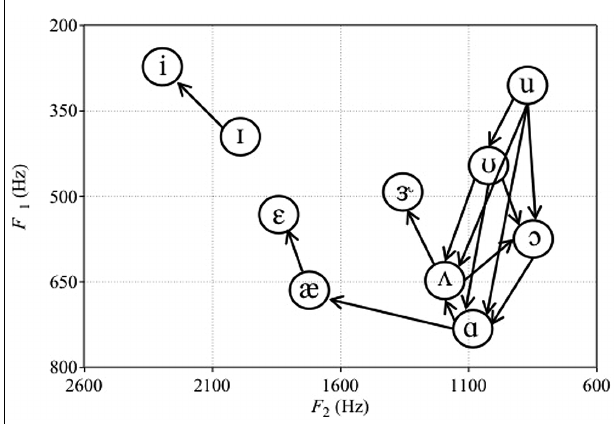
FIGURE 1 | Plot of the asymmetries in vowel discrimination of vervets from Sinnott (1989). Arrows represent the direction of change that was easier to discriminate. For macaques, only the A - 2 contrast was easier to discriminate than the 2 - A contrast. F1 and F2 values of vowel tokens are those reported in Sinnott